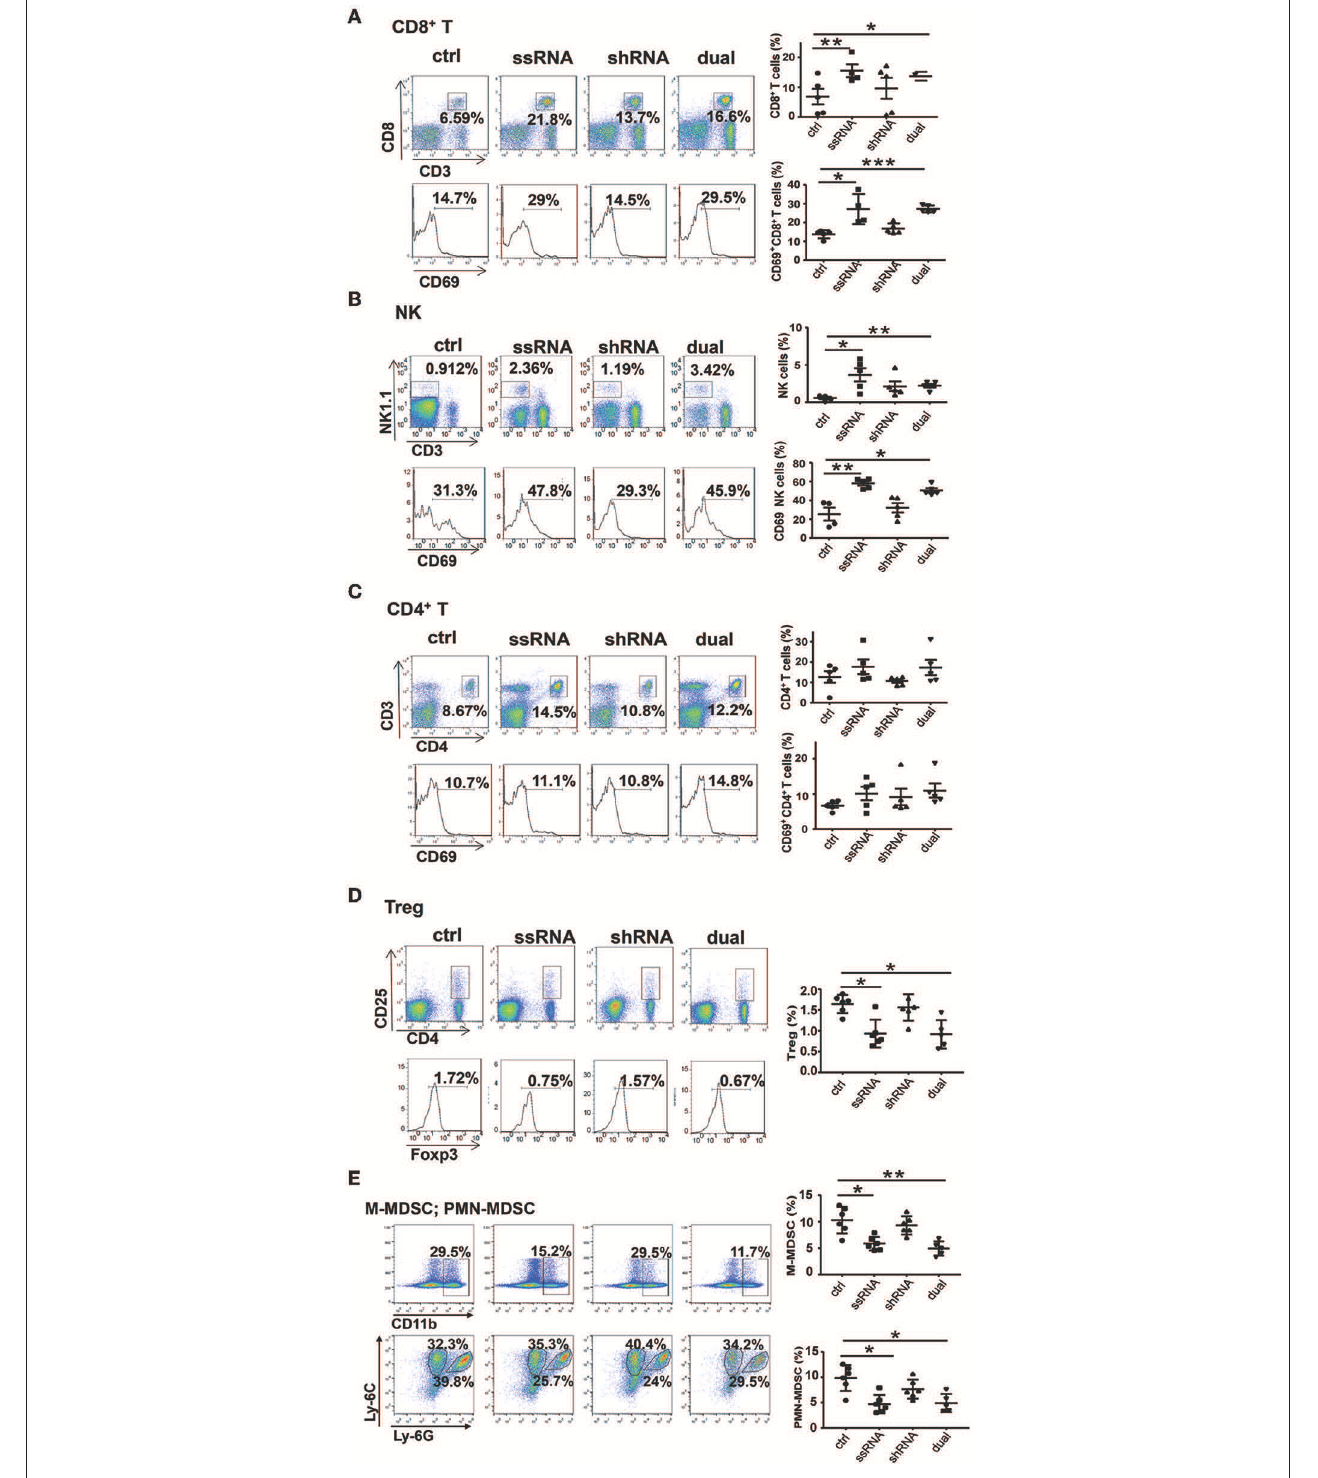
FIGURE 3 | Treatment with bifunctional vector enhances the activation of NK and CD8 + T cells in vivo . The percentages and activation of tumor-infiltrating leukocytes in C57BL/6 mice was determined via flow cytometric analysis. (A) CD8 + T cells. (B) NK cells. (C) CD4 + T cells. (D) Treg cells. (E) M-MDSCs and PMN-MDSCs. Data are representative of three independent experiments. * P < 0.05, ** P < 0.01, and *** P < 0.001 vs. control group. NK, natural killer; Treg, regulatory T cell; M-MDSC, monocytic myeloid-derived suppressor cell; PMN, polymorphonuclear.